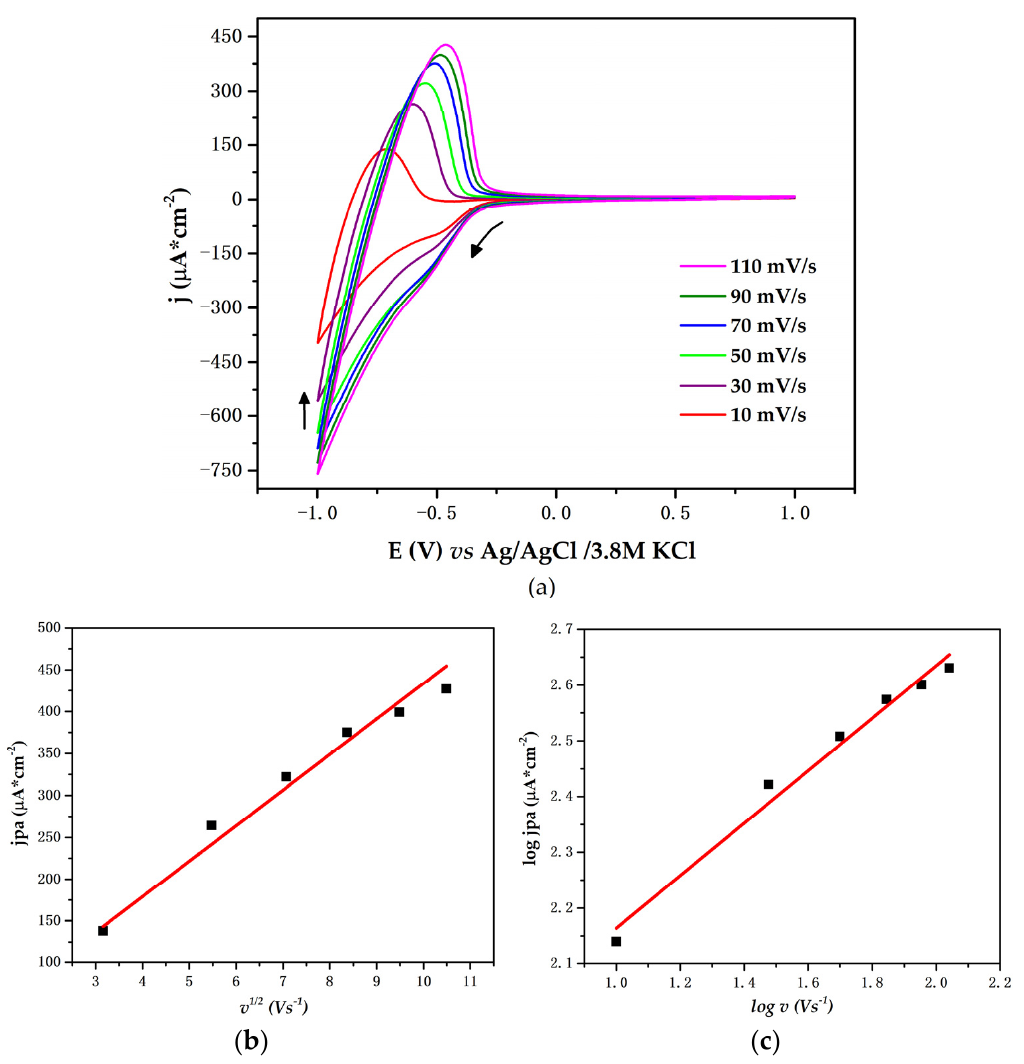
Figure 6. ( a ) CV curve of the working electrode under the effect of scan rate variation (10, 30, 50, 70, 90, and 110 mV/s), using pH 7 PBS and glucose at 1 mM. Arrows depict the sense of potential sweep. ( b ) Plot of anodic peak current versus square root of scan rate. ( c ) Plot of log anodic peak current versus log scan rate.